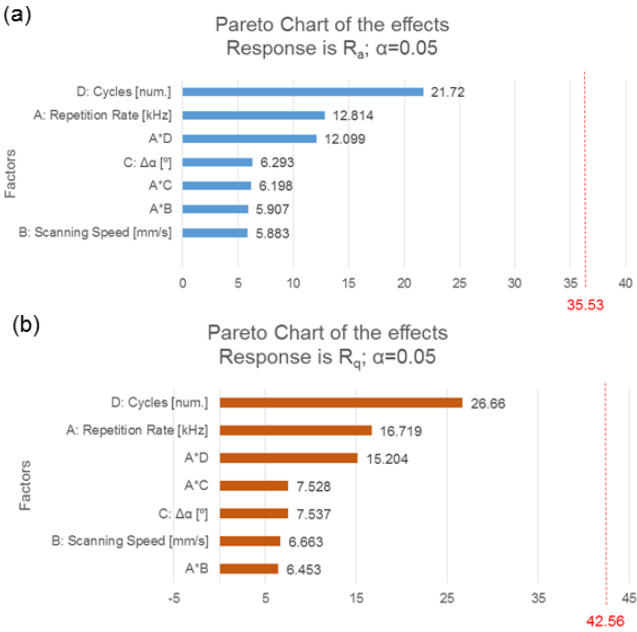
Figure 12. Pareto diagram for the significance of the effects of the variables in the DOE regarding R a ( a ) and R q ( b ). Variable D: number of cycles shows a relatively stronger significance than the others in both cases.